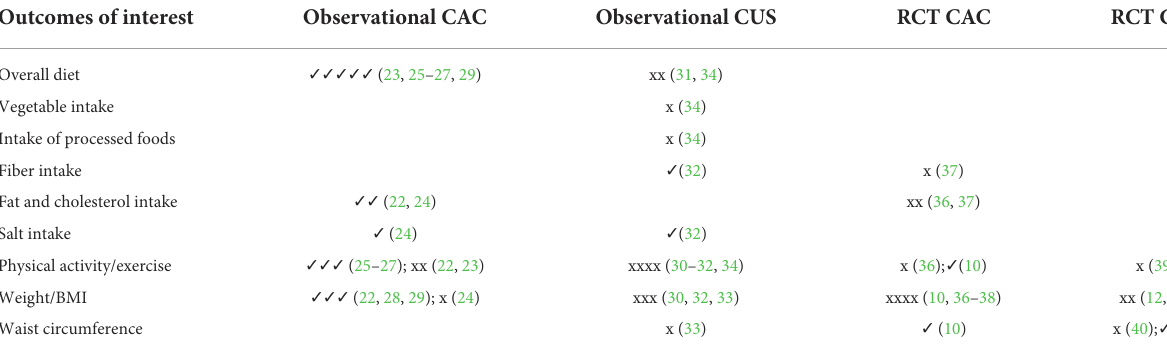
TABLE 4 Changes in diet, physical activity and anthropometric measures in observational studies and RCTs. Outcomes of